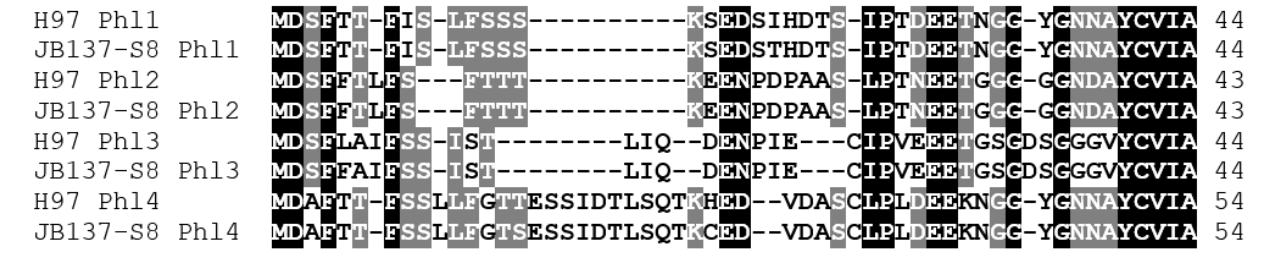
Figure 6. Sequence alignment of pheromone precursors of A. bisporus var. bisporus H97 and A. bisporus var. burnettii JB137-S8. Stretches of charged amino acids for possible N-terminal processing [8,93] and the typical CAAX motif at the C-terminus for farnesylation and carboxymethylation [99] are underlined.